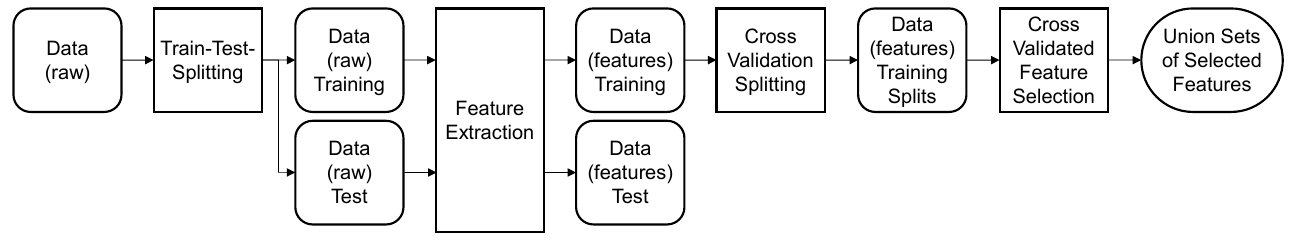
Figure 8. Process of feature extraction and cross ‐ validated feature selection.